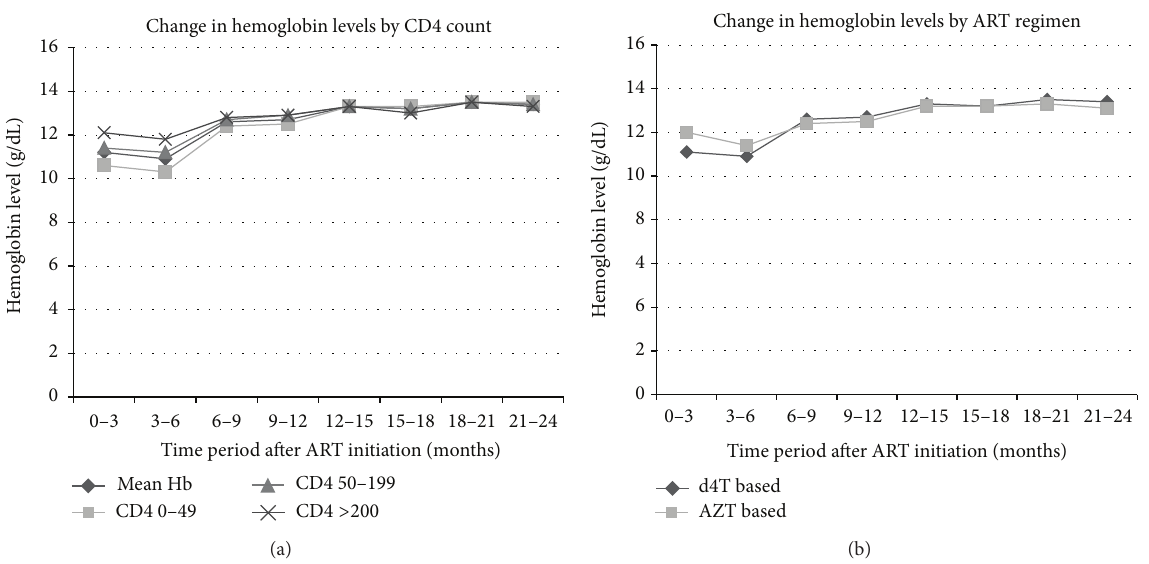
Figure 1: Change in hemoglobin levels by level of immunosuppression and initiating ART regimen amongst patients at the Themba Lethu Clinic in Johannesburg, South Africa ( 𝑛 = 10 , 259 ). Abbreviations: AZT: zidovudine; d4T: stavudine; ART: antiretroviral